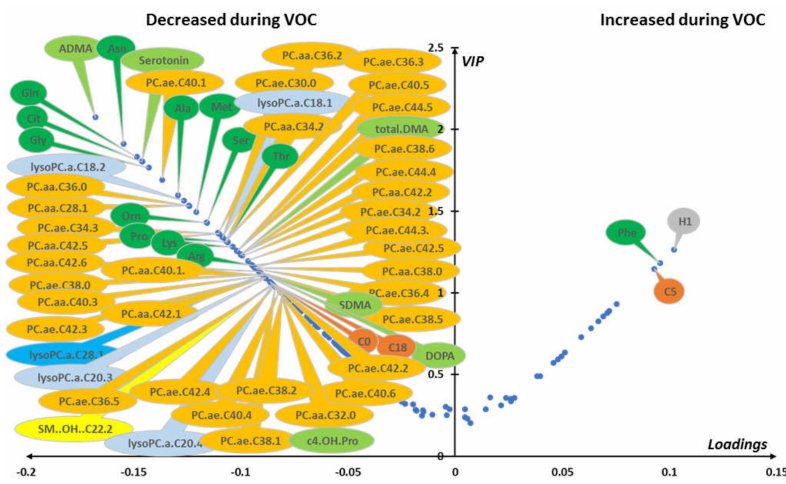
Figure 3. (plasma): Loading vs. variable importance for the projection (VIP; volcano plot) for PLS-DA models constructed from plasma samples. Median loading and VIP were calculated for each metabolite using 4277 best models (BMs) (i.e., AUROC in validation sets (AUROCva) ( ≥ 0.95). Only the most important metabolites, that is, those with VIP ≥ 1, have been labeled. Positive / negative loadings indicate increased / decreased metabolite concentrations during in-crisis compared to out-of-crisis phases. The main features of the metabolomic signature included relatively increased level of hexoses (H1), phenylalanine (Phe), and valeryl-carnitine (C5) during the crisis. On the other hand, the following metabolites were relatively decreased during the crisis: free carnitine (C0) and octadecanoyl-carnitine (C18); 12 amino acids including asparagine (Asn), glutamine (Gln), glycine (Gly), citrulline (Cit), alanine (Ala), proline (Pro), threonine (Thr), arginine (Arg), lysine (Lys), serine (Ser), methionine (Met), and ornithine (Orn); 6 biogenic amines including asymmetric dimethylarginine, symmetric dimethylarginine, and their sum (ADMA, SDMA, and total DMA, respectively), serotonin (Serotonin), 3,4-dihydroxyphenylalanine (DOPA), and cis-4-hydroxyproline (c4-OH-Pro); 5 lysophosphatidylcholines; 12 diacyl phosphatidylcholines (PC aa) and 22 alkyl-acyl phosphatidylcholines (PC ae); and 1 hydroxy sphingomyelin with an acyl chain of 22 carbons and 2 unsaturated bonds (SM.OH.22.2). Color code for metabolite bubbles: hexose: gray; amino acids: green; biogenic amines: light green; (acyl) carnitines: brown;